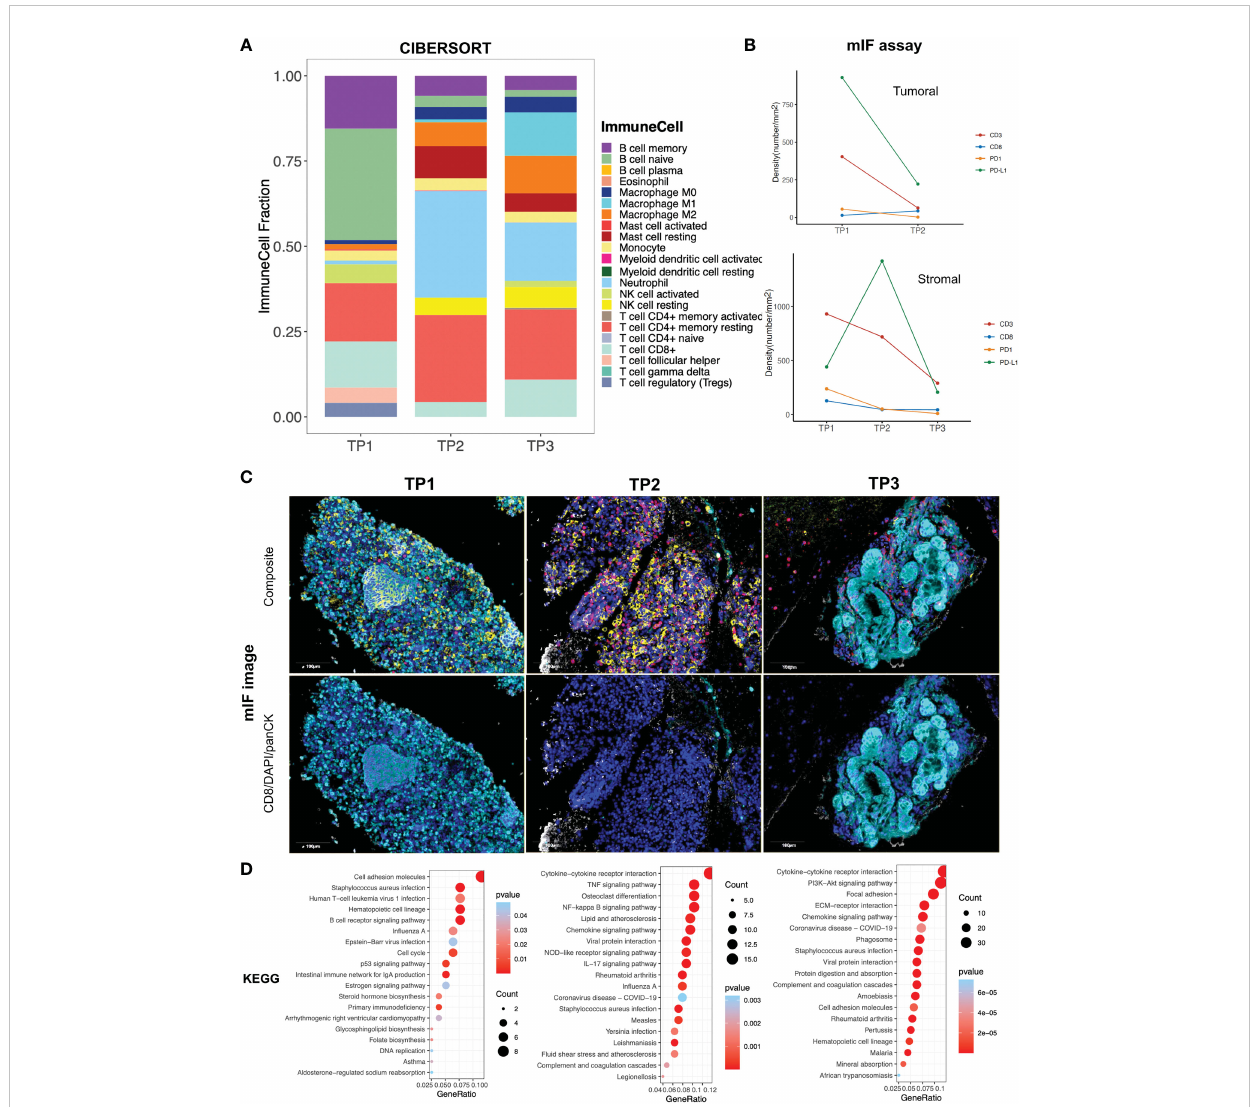
FIGURE 2 The dynamic change of tumor microenvironment. (A) Proportions of various in fi ltrated immune cells estimated by CIBERSORT based on whole transcriptome sequencing (WTS) data; (B) Densities of different multiplex immuno fl uorescence (mIF) markers assessed by inForm image analysis software (PerkinElmer, Waltham, Massachusetts, US); (C) Multiple immuno fl orescent stain captured by Mantra System (PerkinElmer, Waltham, Massachusetts, US), composite fi ve-color images showing the expression of PD-1(green), PD-L1(yellow), CD3 (red), CD8 (white), and panCK (cyan) DAPI(blue) and images showing CD8, DAPI, and panCK markers; (D) KEGG pathway enrichment. TP1: initial relapse; TP2: 1 month after relapse; TP3: 2 months after